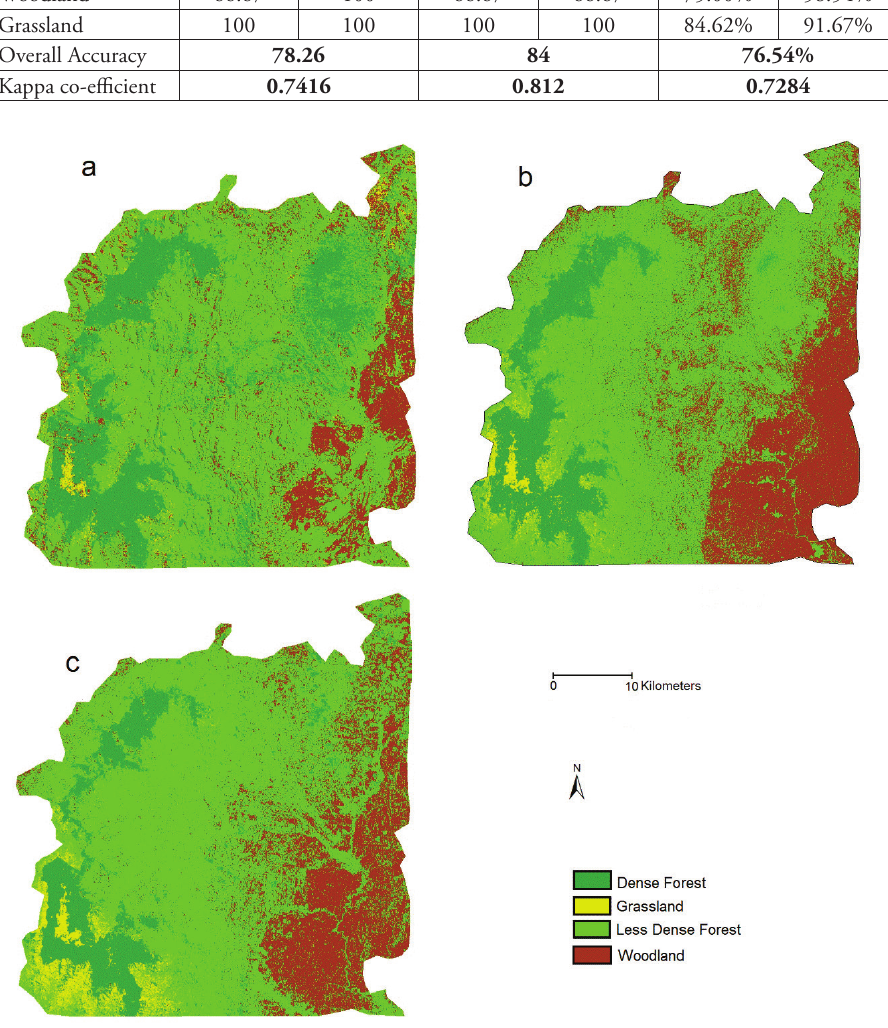
Figure 2. Land use land cover (LULC) maps in 1975 ( a ), 1995 ( b ) and 2012( c ). 11, 267.38 hectares) and increase in grassland (21, 230.01 hectares). However, changes in areas covered by woodland were inconsistent, i.e. increase by 15,884.46 hectares between 1975 and 1985 and decline by 8, 182.03 between 1985 and 2012) – Figure